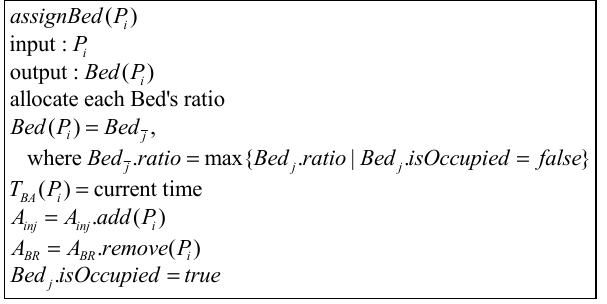
R P = Figure 6. Algorithm for estimating examination process time. Table 2. Weight allocation in the intake room. Bed Type ( ) i b P